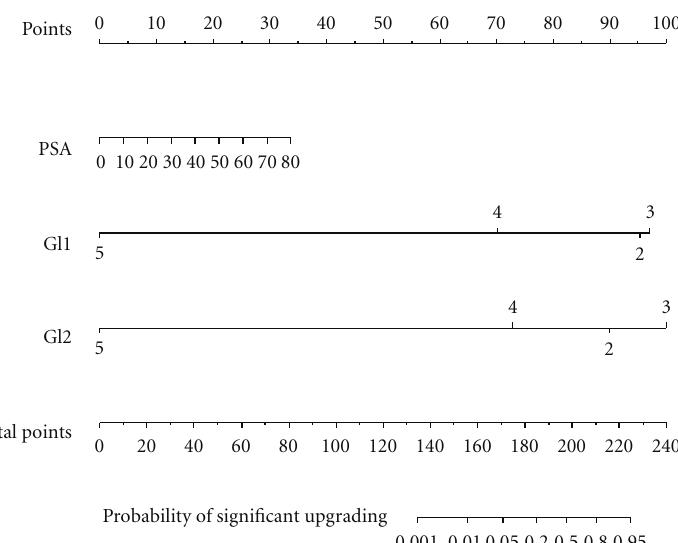
Figure 1: Nomogram based on 508 patients treated at Chiba Cancer Center, for predicting significant Gleason sum upgrading between biopsy and radical prostatectomy. PSA: prostate-specific antigen (ng/mL); Gl1: primary biopsy Gleason score; Gl2: secondary biopsy Gleason score. To obtain the nomogram-predicted probability of significant biopsy upgrading, locate the patient values at each axis, draw a vertical line to the “Points” axis to determine how many points are attributed to each variable value; total the points for all variables, and locate the sum on the “Total Points” line to assess the individual probability of significant biopsy Gleason sum upgrading on the Probability of Significant Upgrading line.